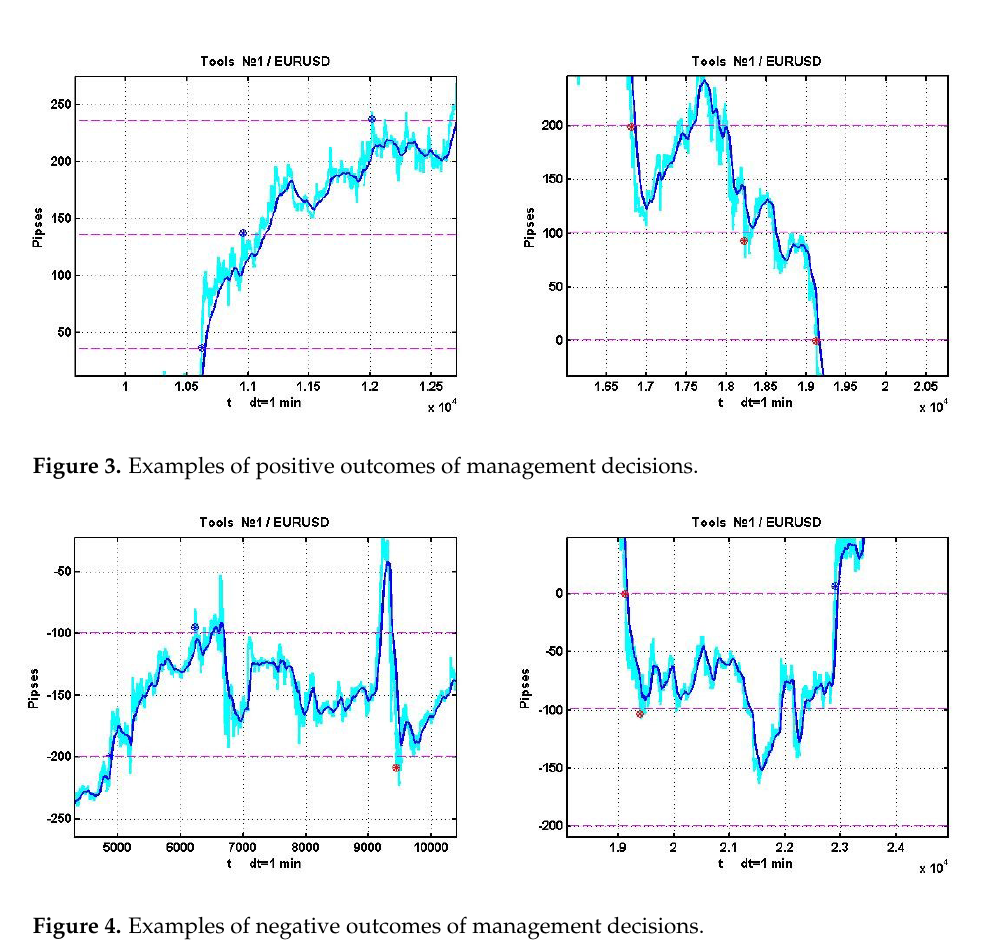
Figure 4. Examples of negative outcomes of management